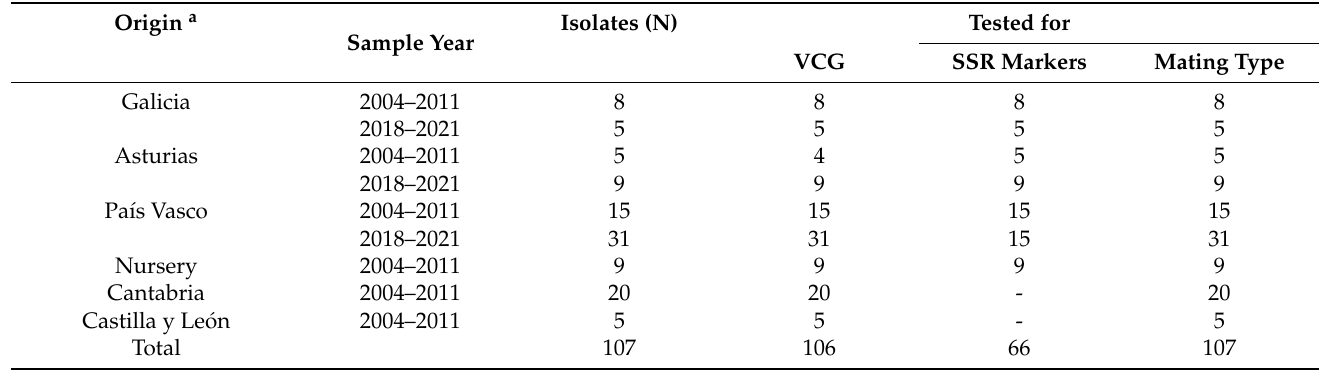
Table 1. Fusarium circinatum isolates from Pinus spp. used for this